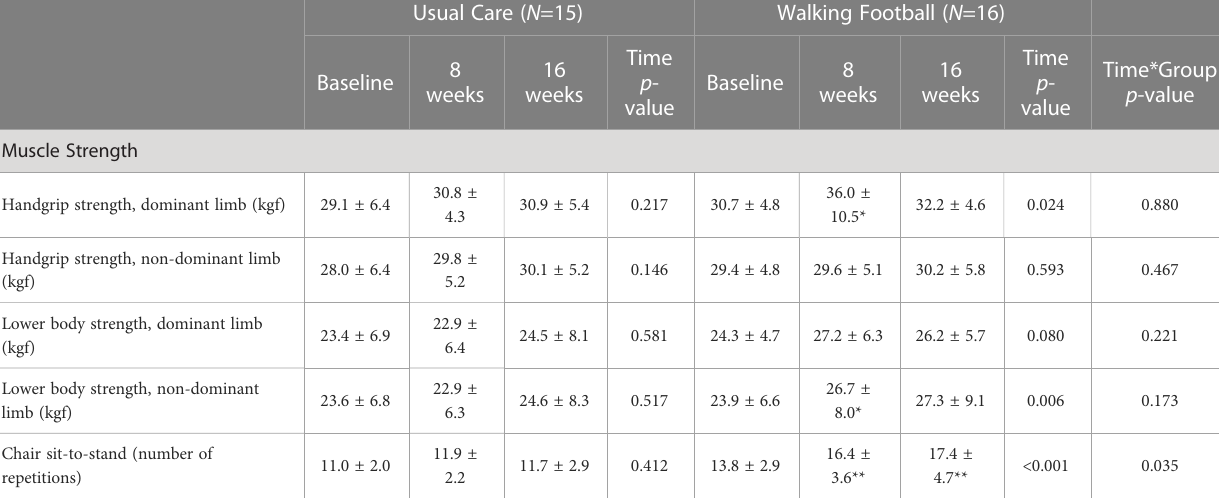
TABLE 3 Changes over time in muscle strength in walking football and usual care groups.